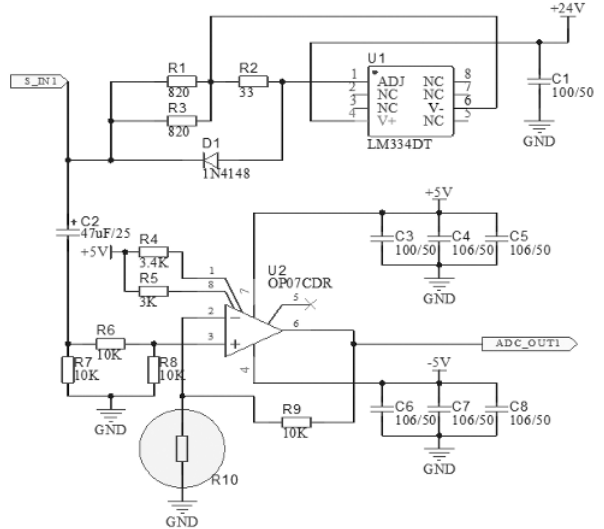
Fig. 2. Schematic of signal conditioning